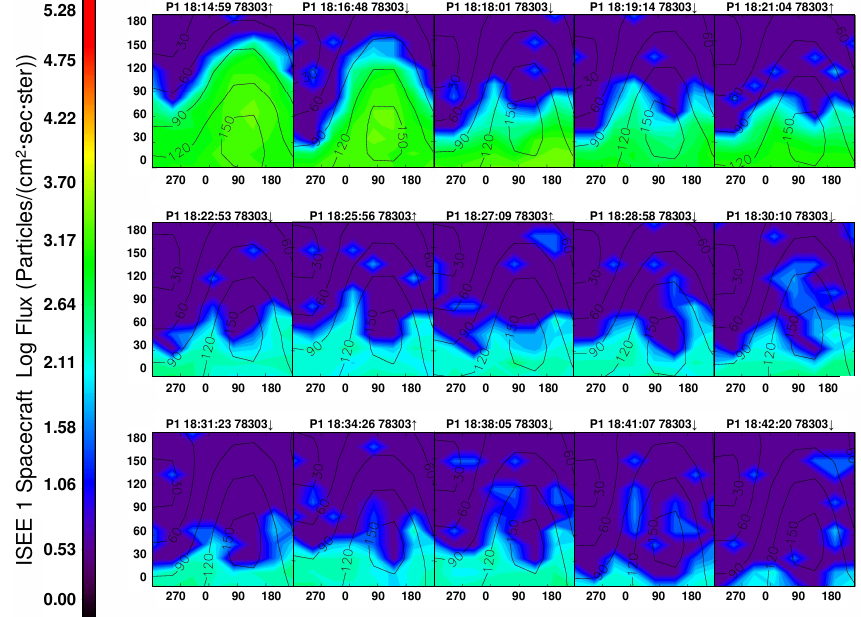
Fig. 5. ISEE-1 MEPE 3-D pitch angle distributions for the time period of 18:15–18:42 UT (Epoch 3 in Fig. 1). The s/c has now exited out the “top” of the CDC, but still observes energetic particles from below until 18:42